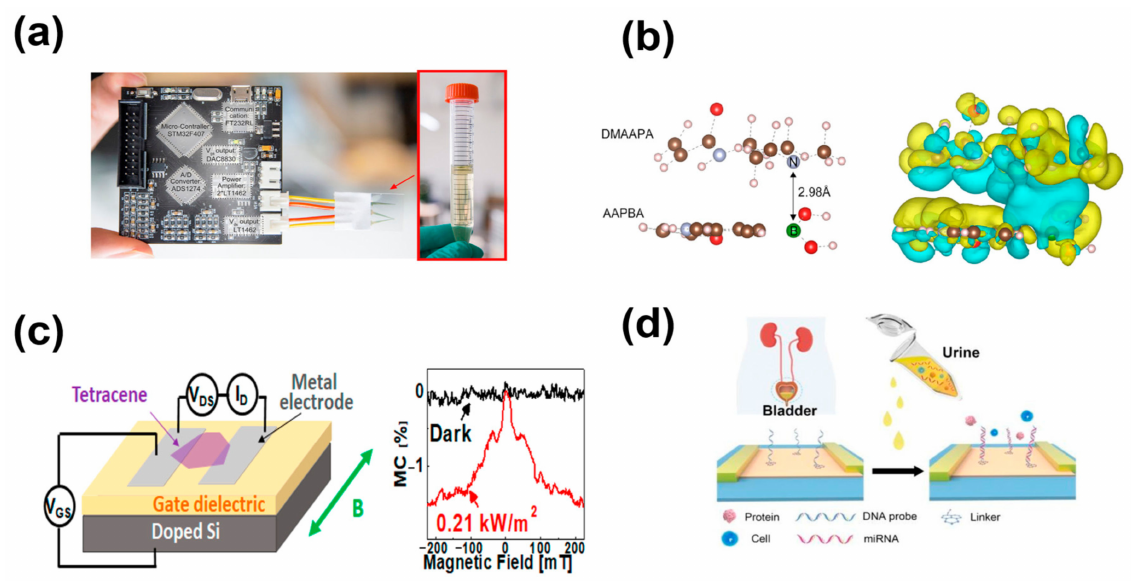
Figure 8. ( a ) For the detection of glucose concentration polymer functionalization graphene sen- sors and functionalization of graphene sensor. ( b ) The difference in surface charge between N- dimethylaminopropyl Acrylamide (DMAAPA) and acrylamide/3-acrylamidophenylboronic acid (AAPBA), with yellow representing charge accumulation and blue representing charge loss. ( c ) De- vice structure diagram based on OFET principle and corresponding transmission output curve. ( d ) Schematic diagram of nucleic acid detection in a biosensor. ( a ) Reproduced with permission